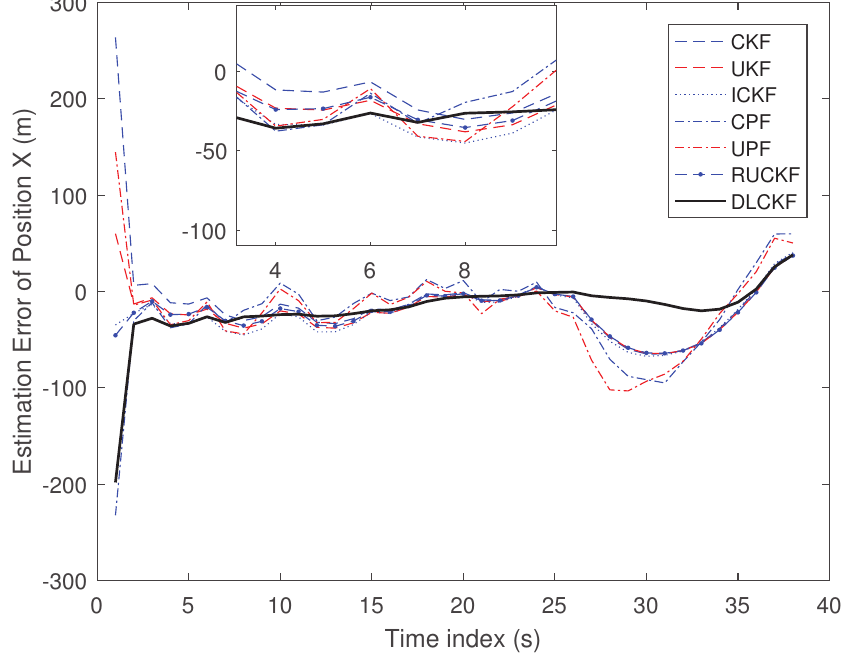
Figure 5. Estimation Error of Position X